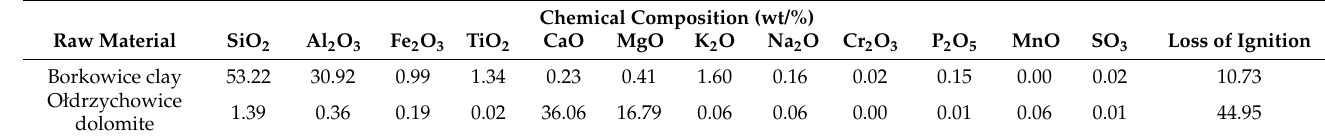
Chemical analysis of Borkowice clay shows a significant amount of Al 2 O 3 (30.92%) and low content of coloring oxides: Fe 2 O 3 and TiO 2 (0.99% and 1.34%, respectively). XRF